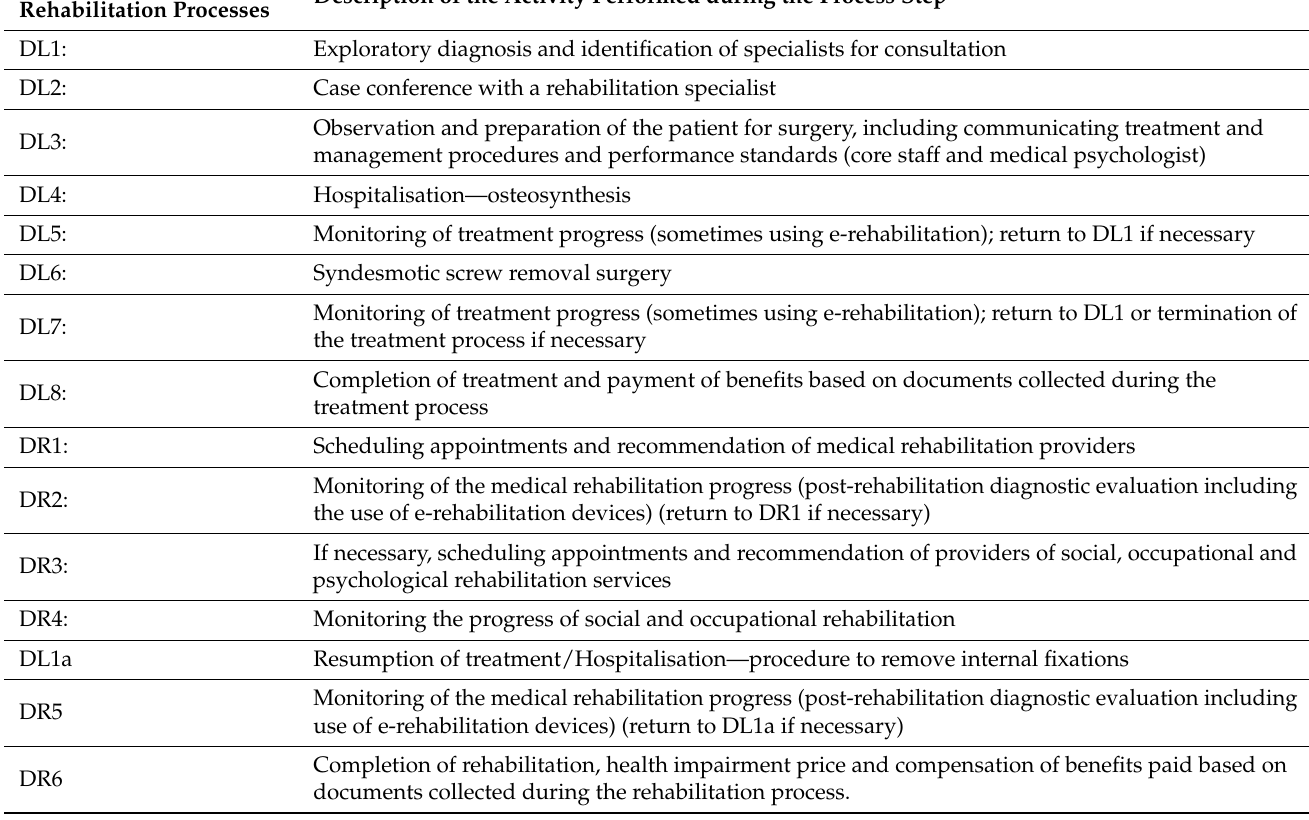
Table 1. Steps in the treatment and rehabilitation processes of a selected injury (trimalleolar fracture of ankle